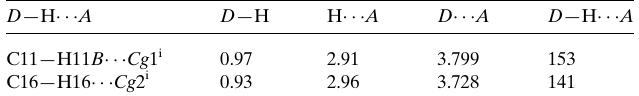
Table 1 Hydrogen-bond geometry (A˚ , (cid:2) ).